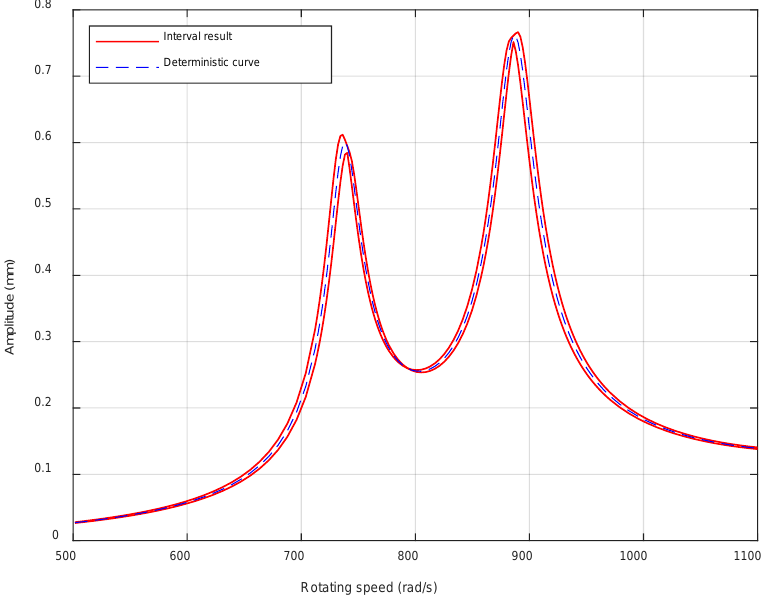
Figure 7. Dynamic response of the HP rotor with uncertain geometric length.